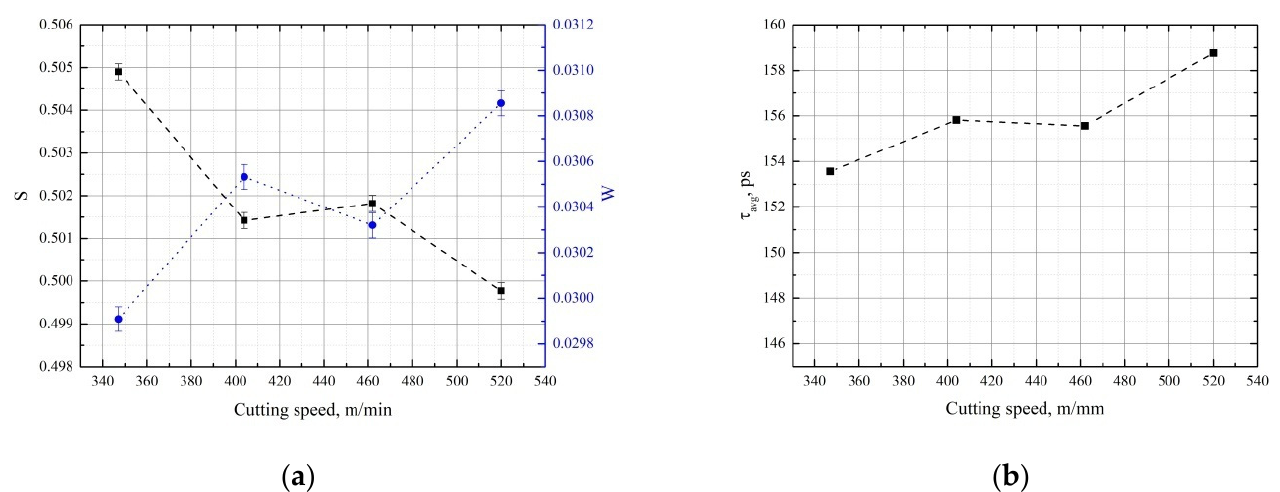
Figure 2. Dependencies of S (black) and W (blue) parameters ( a ) and average positron lifetime ( b ) as a function of cutting speed for GCr15 steel.